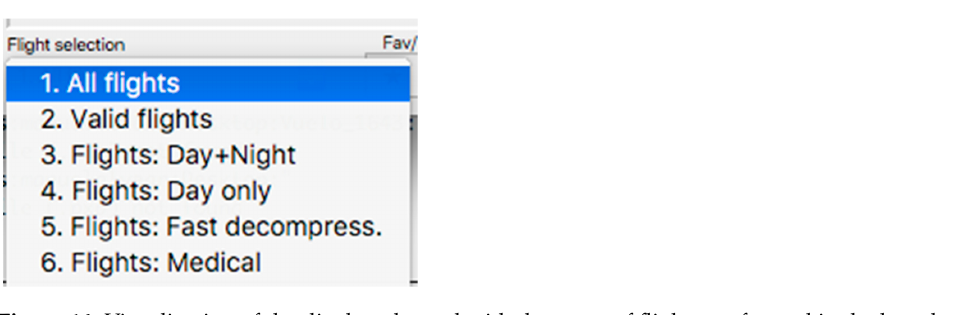
Figure 13. Phases of the oxygen saturation curve (blue line) during a simulated flight. DT—discon- nection time (black arrow), DeD—desaturation delay (dashed red arrow), HD—hypoxia delay (dashed green arrow), DeT—desaturation time (solid red arrow), HT—hypoxia time (solid green arrow), RT—recovery time (dashed black arrow), DM—disconnection from oxygen mask, RM— reconnection to oxygen mask.